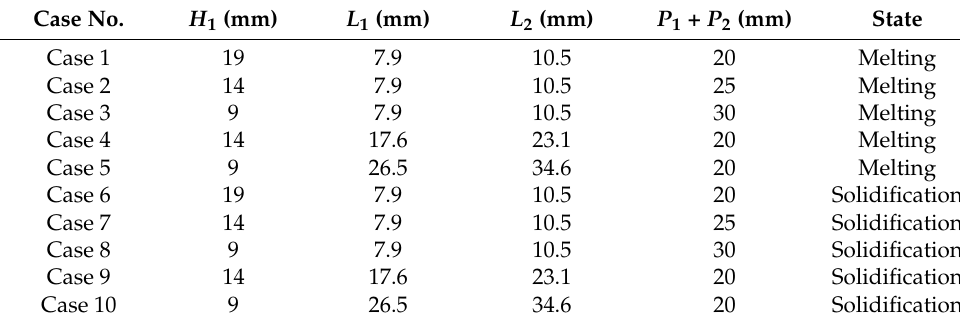
Table 2. Bifurcated fin parameters and discussed